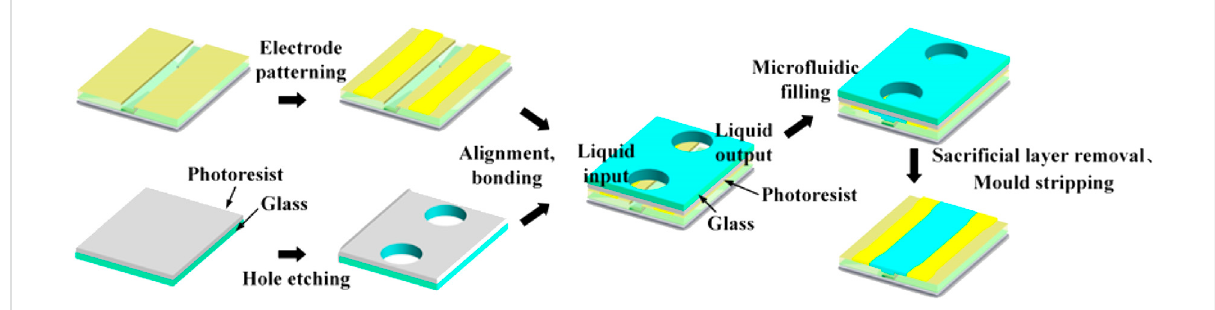
FIGURE 12 The schematic diagram of the fabrication process of organic polymer waveguides based on micro fl uidic injection